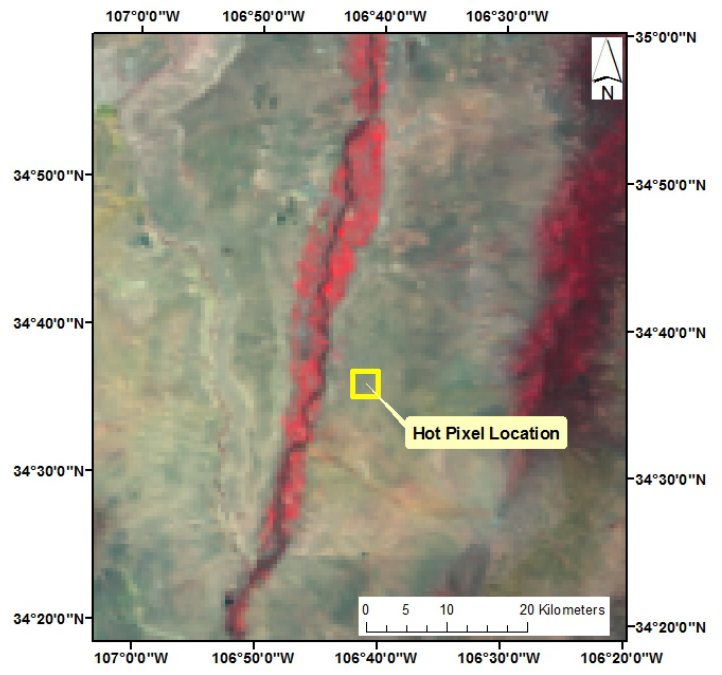
Figure 4. Hot pixel location used to calibrate METRIC for all MODIS